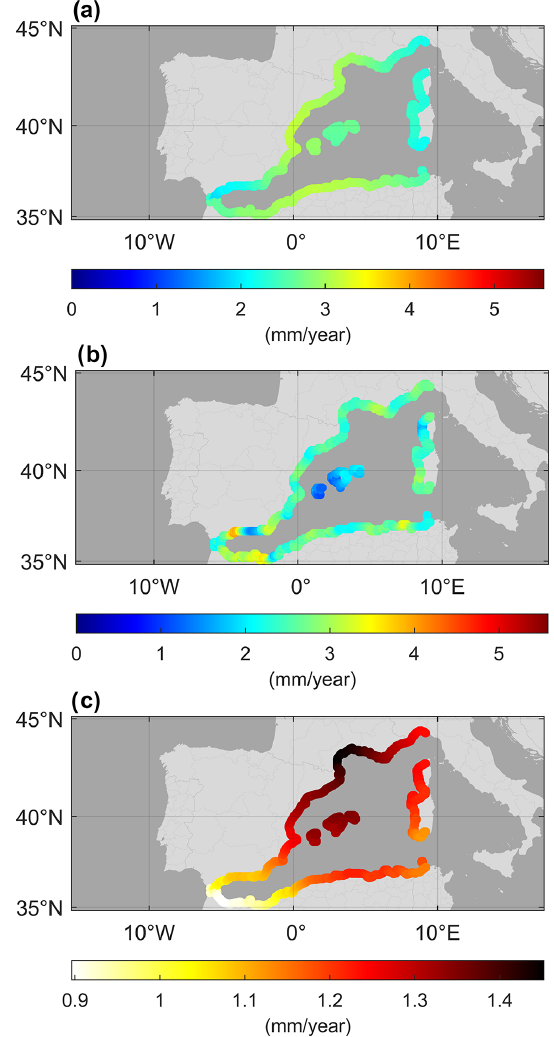
Figure 9. (a) Sea level trends of the reconstructions for the period covered by altimetry (1993–2019). (b) Sea level trends of the al- timetry series at the points closest to the coast. (c) Sea level trends calculated for the total period of the reconstructions (1884–2019) shown with a different color